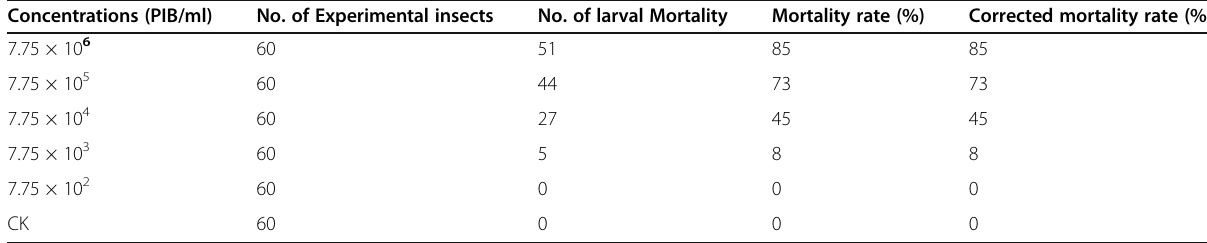
Table 3 Cumulative mortality rate of 3rd instar larvae of Spodoptera litura infected at different concentrations of microencapsulated virus Concentrations